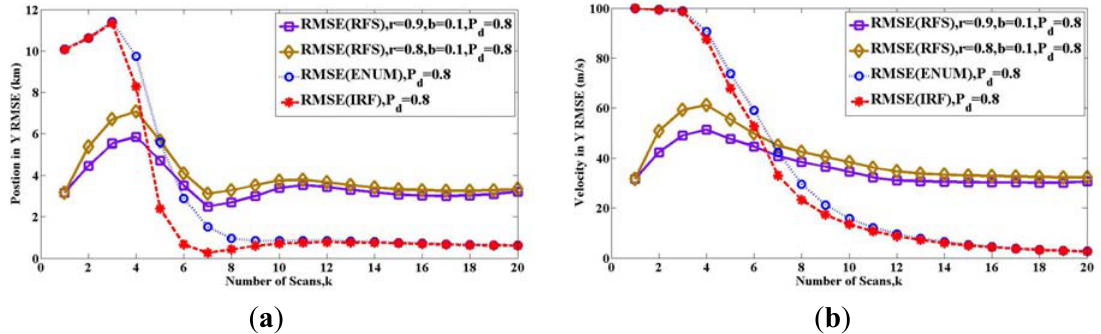
Figure 6. Comparisons of bounds with different initial existence probability b: ( a ) Position in Y axes ( b ) Velocity in Y